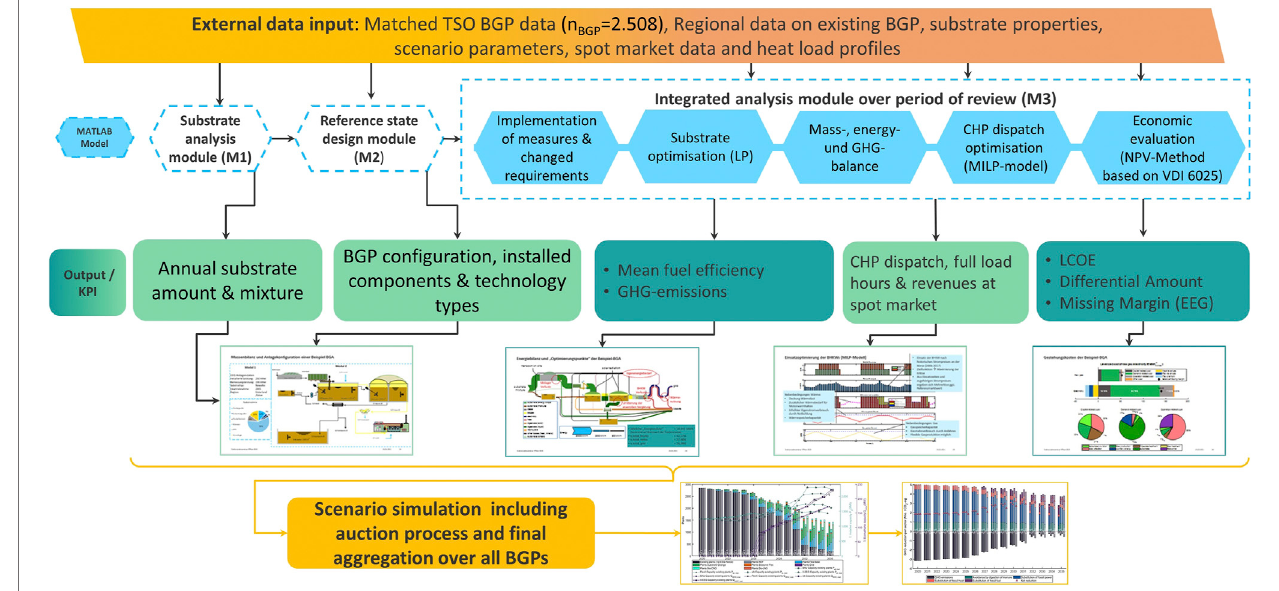
FIGURE1| Overviewoftheplant-speci fi cmodelforexistingbiogasplants;BGP,Biogasplants;MILP/LP,Mixed-integerlinearprogramming;CHP,combinedheat and power; GHG, Greenhouse gas; NPV, Net present value; LCOE, Levelized cost of energy/electricity.